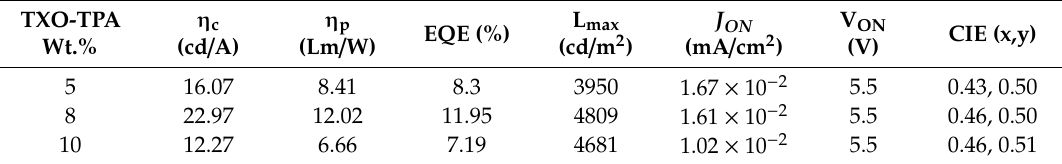
Figure 8. Device characteristics for structure ITO/PEDOT:PSS (40 nm)/PVK:OXD7:TXO-TPA (x wt.%) (40 nm)/TPBi (40 nm)/LiF (1 nm)/Al (100 nm) deposited from chlorobenzene. ( a ) Current density vs. voltage vs. luminance, ( b ) current efficiency vs. luminance, ( c ) EQE vs. luminance, and ( d ) electroluminescence spectra for 5, 8, and 10 wt.% (at 14 V). Table 5. Summary of results obtained for device with structure ITO/PEDOT:PSS (40 nm)/PVK:OXD7:TXO-TPA (x wt.%) (40 nm)/TPBi (40 nm)/LiF (1 nm)/Al (100 nm) deposited from chlorobenzene. (Max EQE values at > 5 cd/m 2 ).